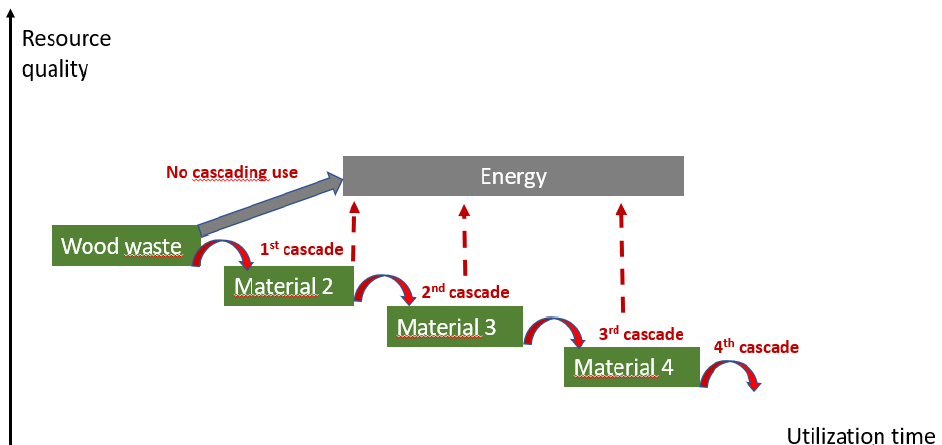
Figure 1. Cascading effect of wood waste.